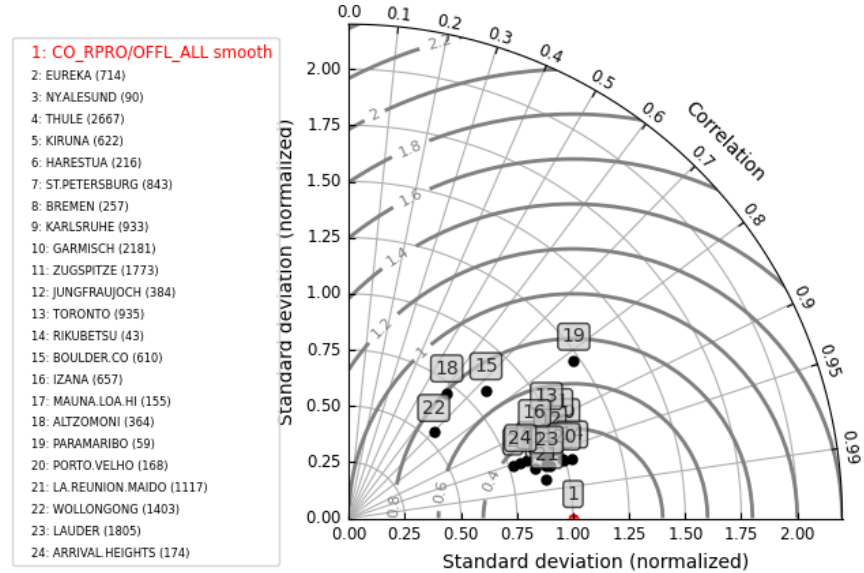
Figure 32. Taylor diagram for daily mean differences between S5P and NDACC CO column data smoothed with S5P a priori and additionally smoothed with the S5P column-averaging kernel at 23 NDACC stations within the period between November 2017 and September 2020. Spatial co-location with radius of 50km and time of ± 3h around the satellite overpass was used. The stations are sorted with decreasing